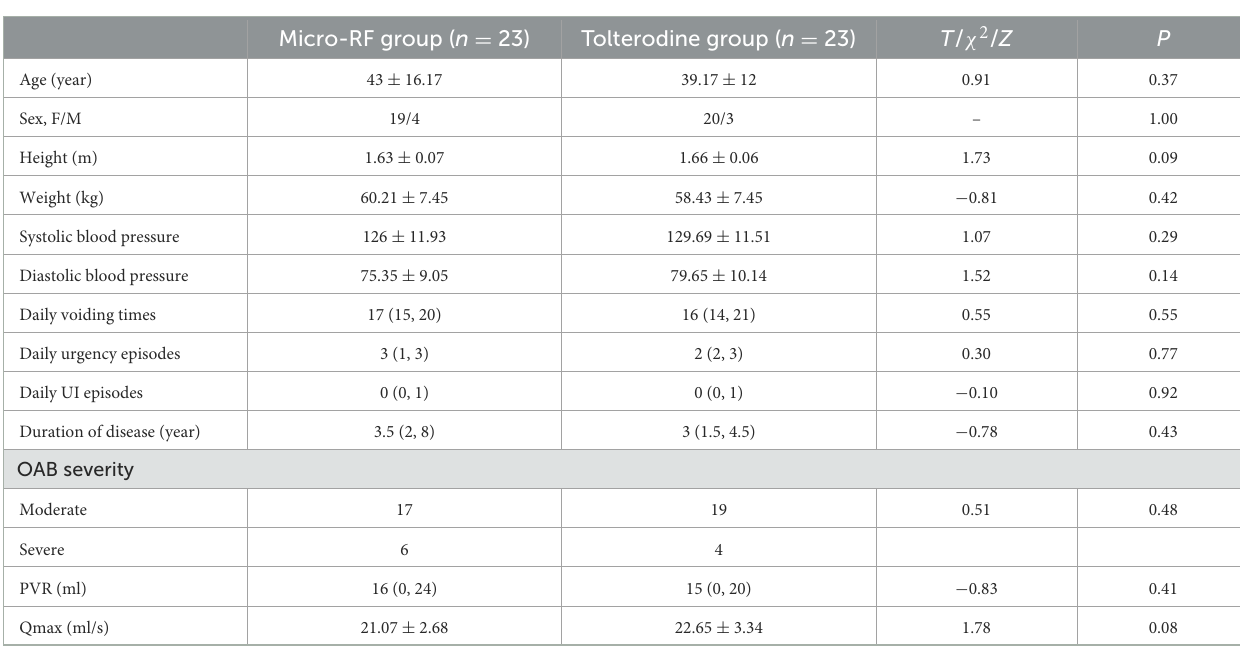
TABLE 2 Baseline characteristics of the